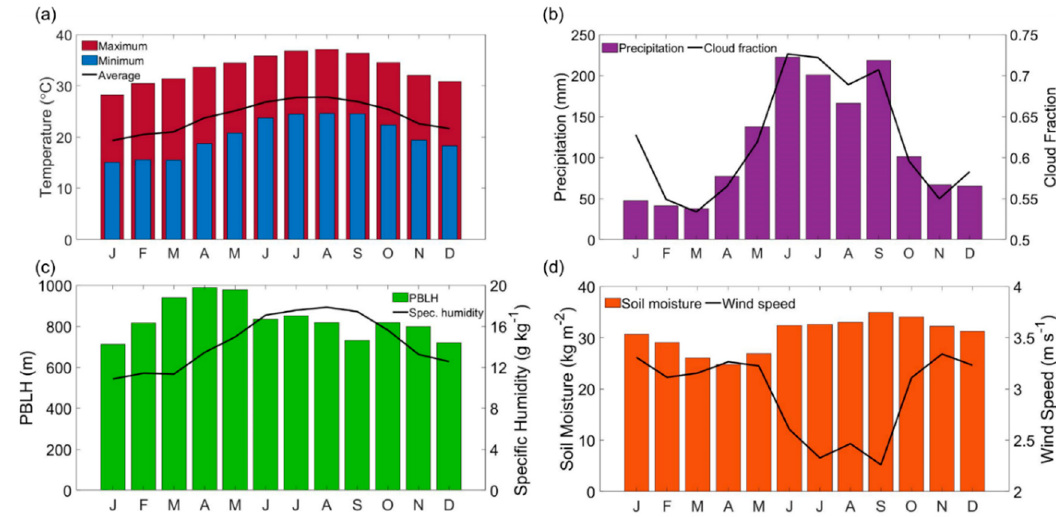
Figure 2. Monthly profiles of ( a ) maximum / minimum temperature (NADP) and average temperature (Environmental Protection Agency (EPA) air quality system (AQS)), ( b ) precipitation (NADP; bars) and cloud fraction (moderate resolution imaging spectroradiometer (MODIS)-Aqua; curve), ( c ) planetary boundary layer height (planetary boundary layer height (PBLH)-modern era-retrospective analysis for research and applications (MERRA-2); bars) and specific humidity (global land data assimilation system (GLDAS); curve), and ( d ) soil moisture 0–10 cm (GLDAS; bars) and wind speed (EPA AQS; curve).